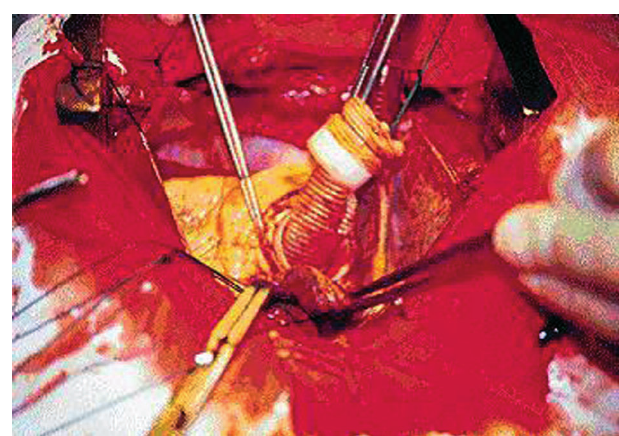
Fig. 1 – Surgical treatment of type A acute dissection of the aorta. Preparation of the intraluminal prosthesis with two rings